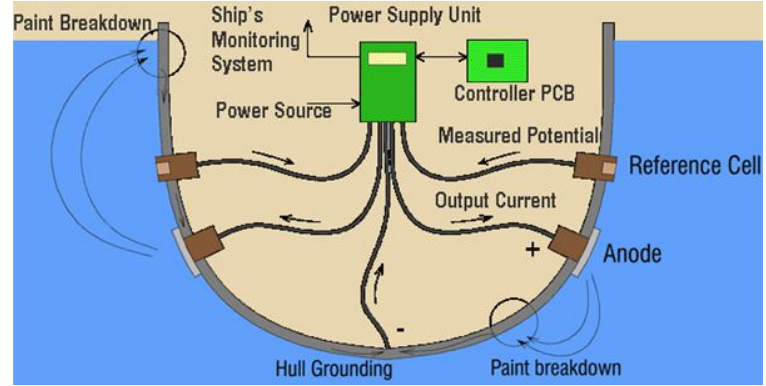
Figure 1. Hexagonal tiling under small cell